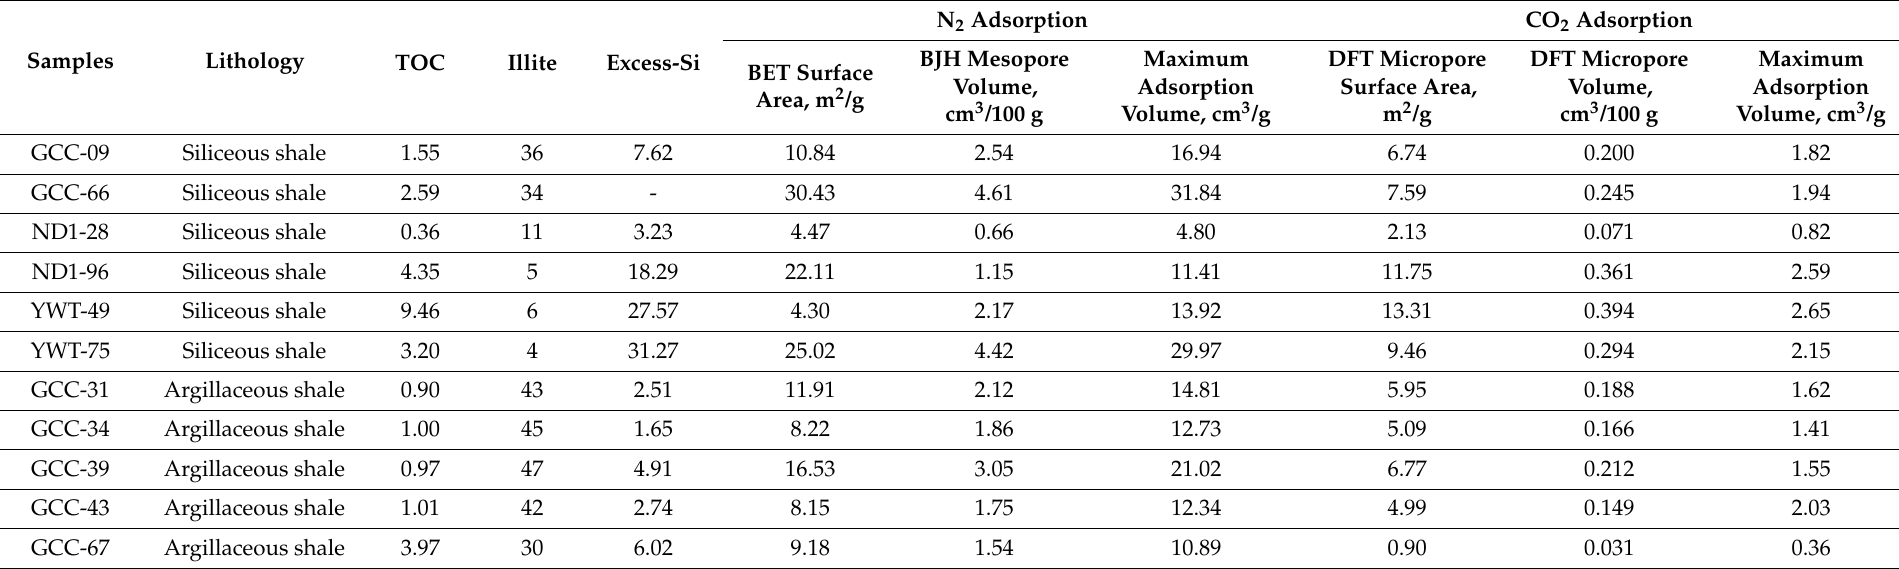
Table 2. Micropore and mesopore volumes and surface areas based on gas